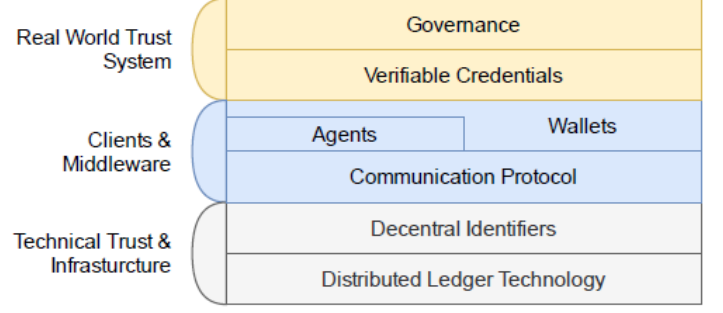
Figure 1. Schematic overview of the SSI